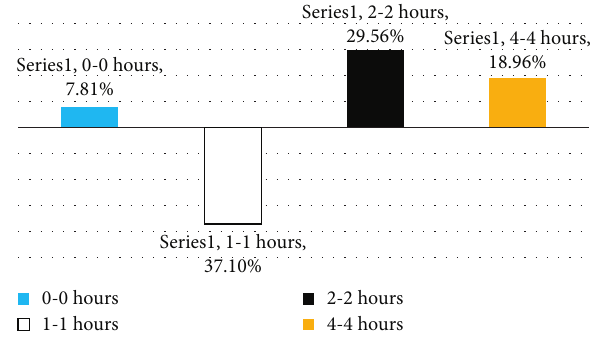
Figure 4: Effects of ethanolic extract of Senna occidentalis (L.) roots part on glucose-loaded induced hyperglycemia in rats when compared within groups to standard glibenclamide